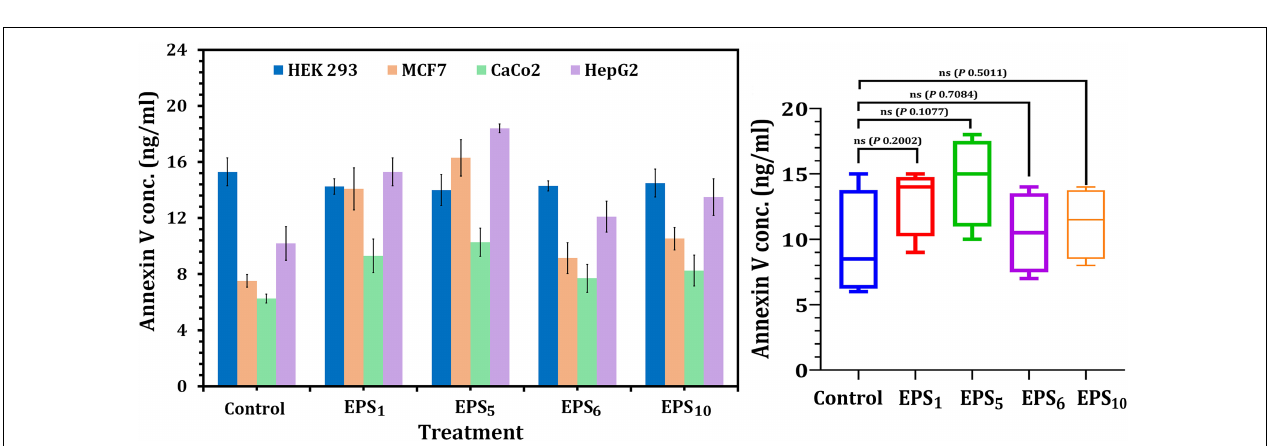
Figure 3 | Cytotoxicity of EPSs against HEK293, MCF7, CaCo2, and HepG2 using MTT assay. EPS 1 , EPS derived from S. thermophilus DSM 24731; EPS 5 , EPS derived from L. delbrueckii ssp. bulgaricus DSMZ 20081 T ; EPS 6 , EPS extracted from L. fermentum DSMZ 20049, and EPS 10 , EPS derived from B. longum ssp. longum DSMZ 200707.